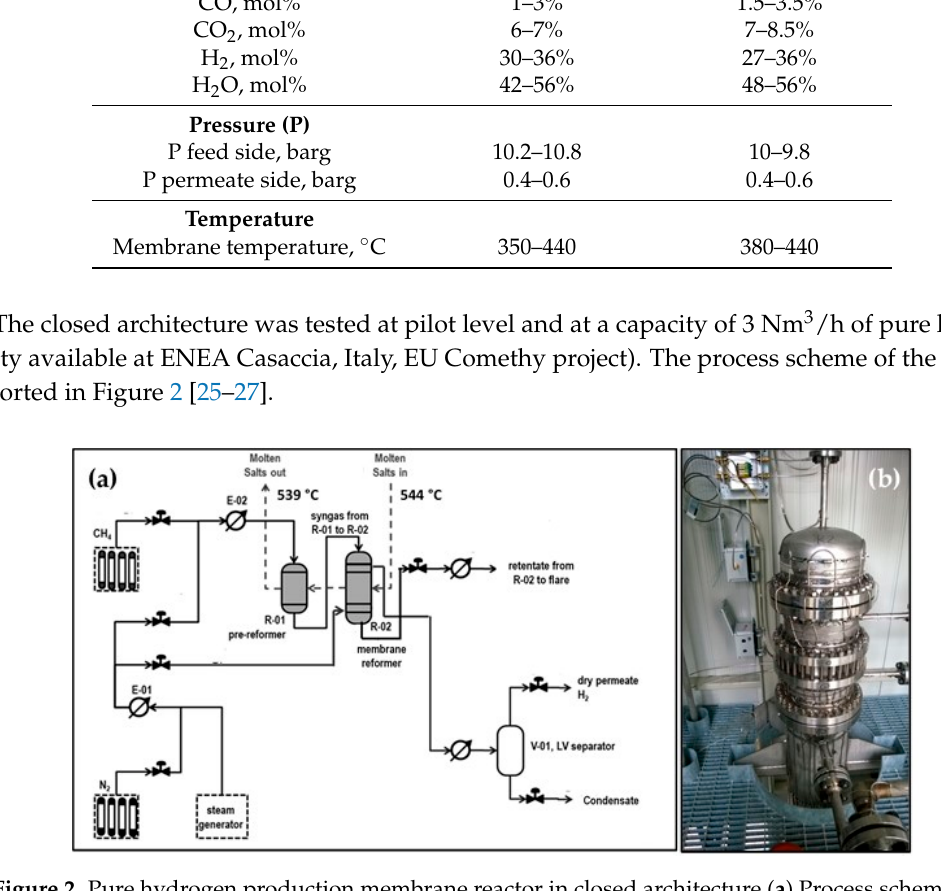
Table 3. Main operating conditions for two-stage reaction and separation configuration.